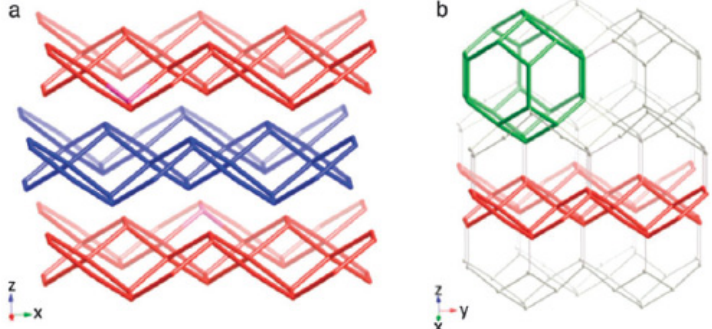
Figure 8. ( a ) 2-D ZIF-L along z, ( b ) sod topology of ZIF-8. Relationship between ZIF-8 and ZIF-L: ZIF-8 framework (grey color) with a sodalite cage highlighted in green, and the layer corresponding to ZIF-L in red. Reprinted with permission from [161], copyright 2013 RSC.